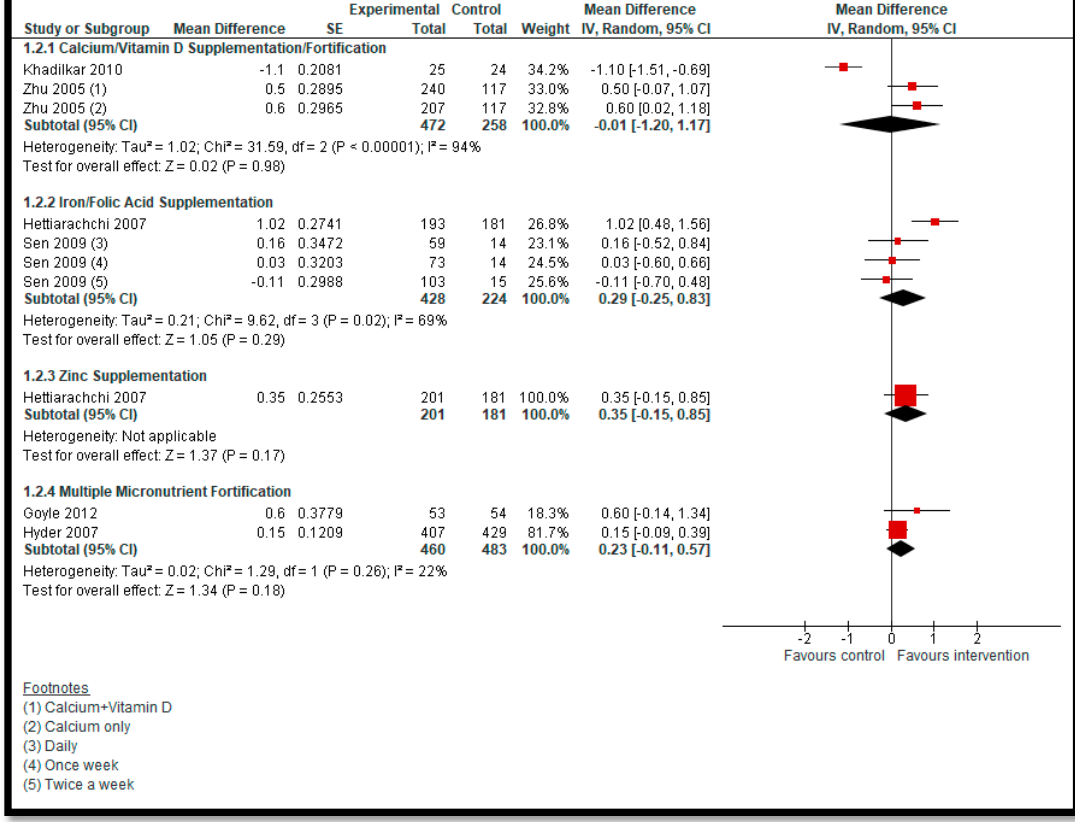
Figure 5. Impact of micronutrient supplementation/fortification on hemoglobin. 3.5.3. Comparison 3: Macronutrient supplementation